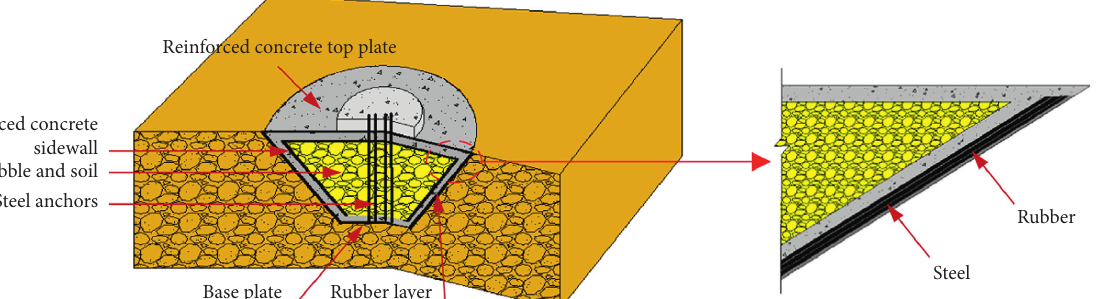
Figure 1: Sketch of the CHFRF.